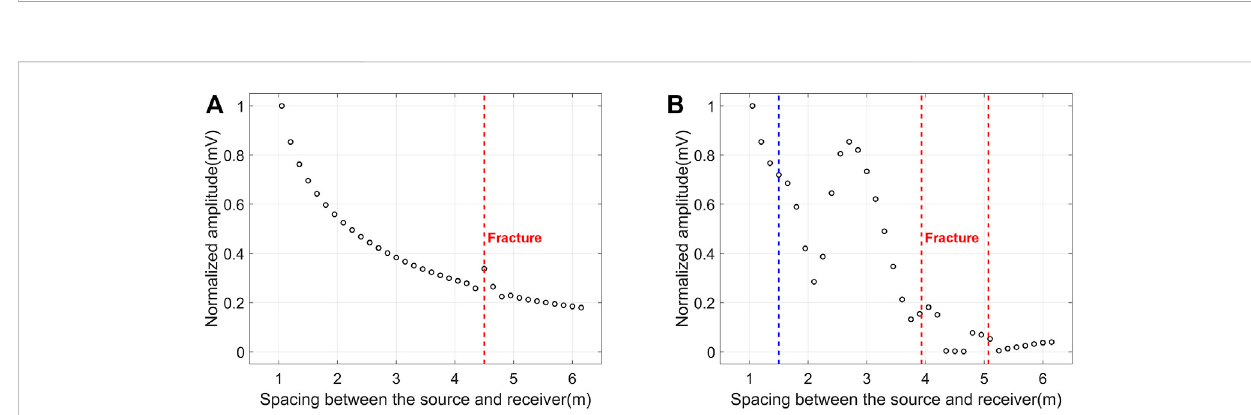
FIGURE 7 Normalized amplitude of monopole P wave versus source-receiver spacing. The fracture width is 40 mm and fi lled with calcite. (A) The fracture dip angle is 90 ° , red dotted line stands for the position where the fracture intersected with the borehole; (B) The fracture dip angle is 10 ° , red dotted lines standsforthepositionswherethefractureintersected withtheborehole,bluedottedlinestandsforthepositionwhere thePwaveamplitudehasalready been affected by the